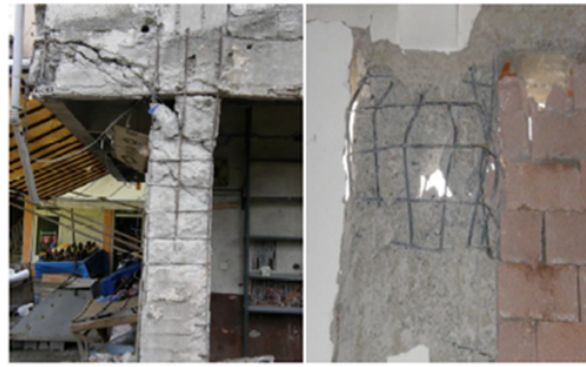
Figure 14. Damage caused by excess stirrup intervals in the con- finement zones of columns (Onen et al.,